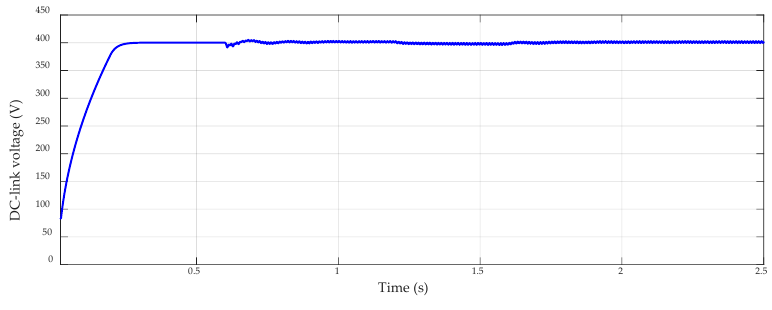
Figure 6. DC-link voltage.